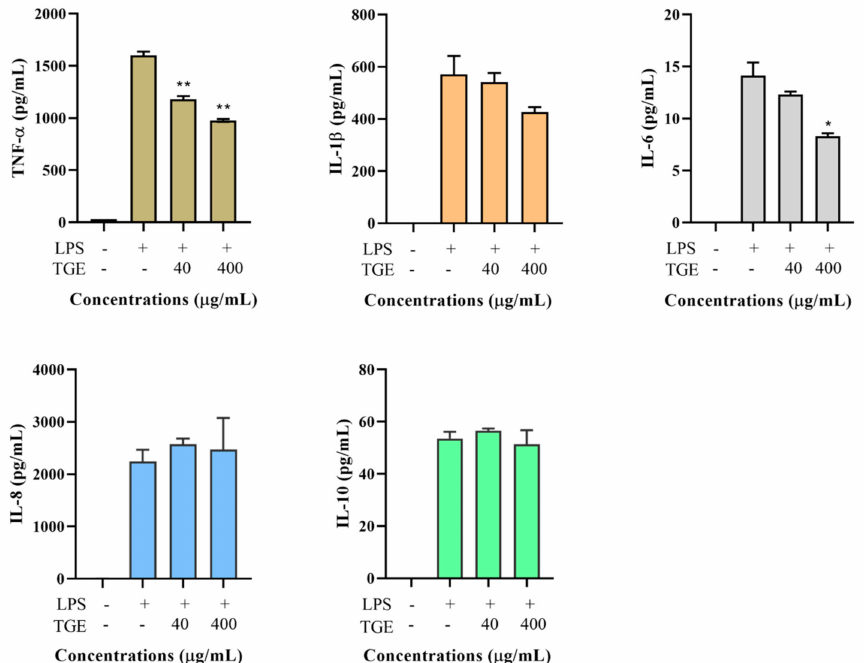
Figure 3. Effect of TGE on LPS-induced TNF- α , IL-1 β , IL-6, IL-8, and IL-10 productions in the THP-1 cell culture medium. Data are shown as the mean ± SD of three repetitions. * p < 0.05 and ** p < 0.01 for comparison of LPS stimulation with and without ginseng extract